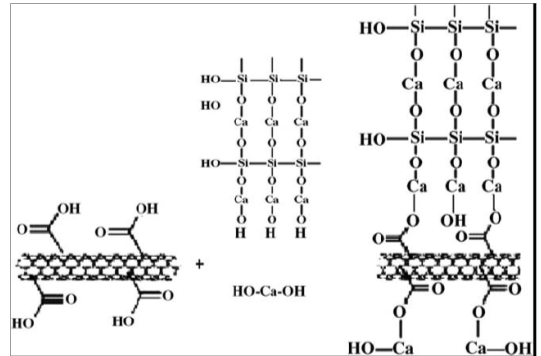
Figure 11: Reaction scheme between carboxylated nanotube and hydrated phases of cement (Ca(OH) 2 and C–S–H) [13].